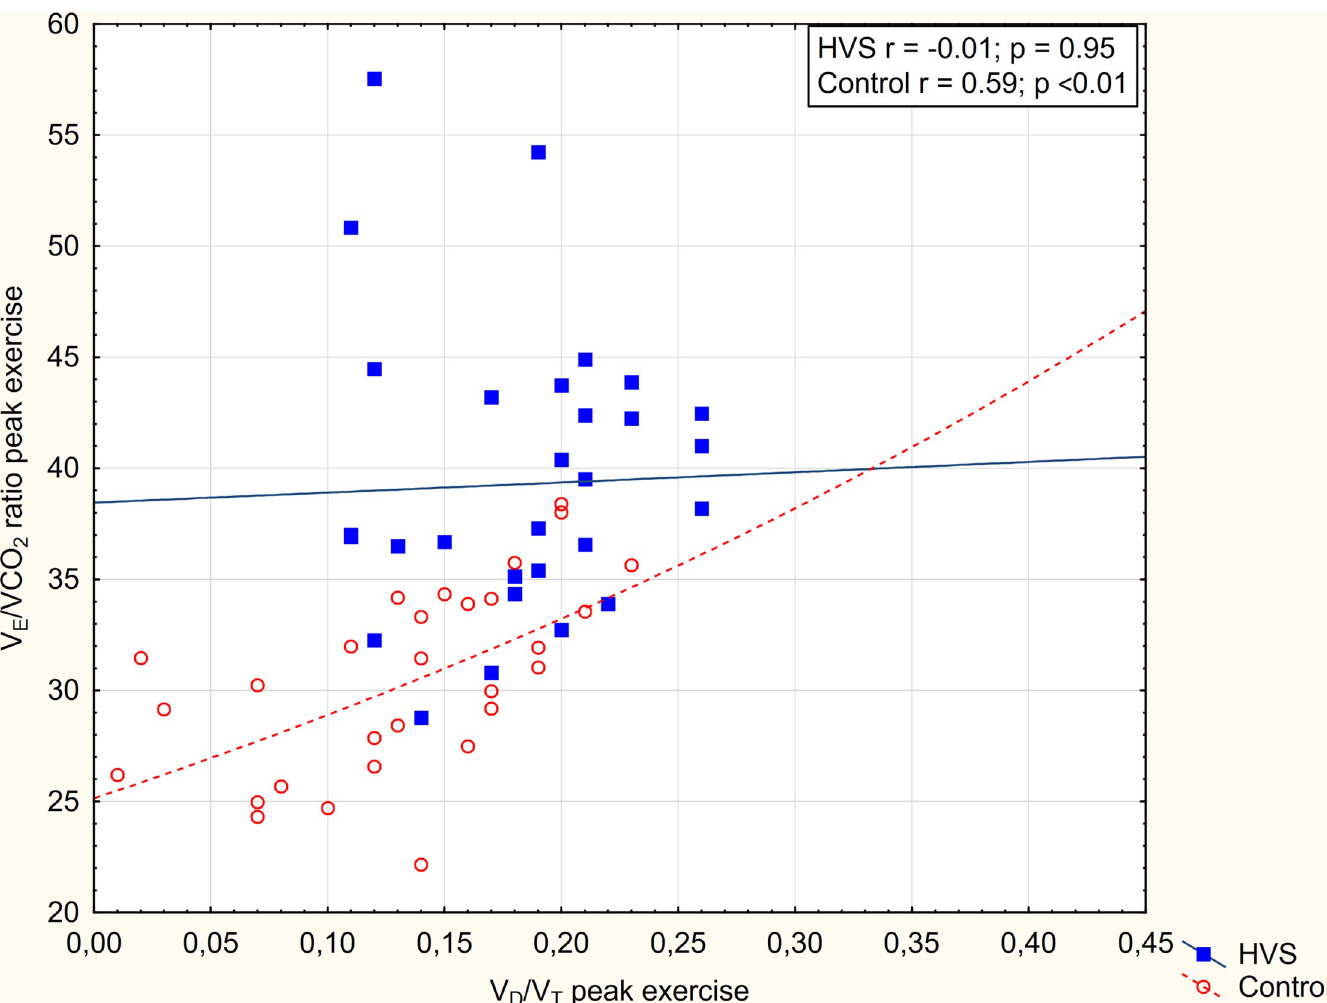
Fig 2. Relation of V E /VCO 2 and V D /V T in patients with HVS and controls. Slopes of V E /VCO 2 and ratio of tidal volume to dead space (V D /V T ) at peak exercise are compared in patients with HVS and controls. The shift of the slope of this relationship in patients with HVS is consistent with the observed lower PaCO 2 (i.e. increased ventilatory